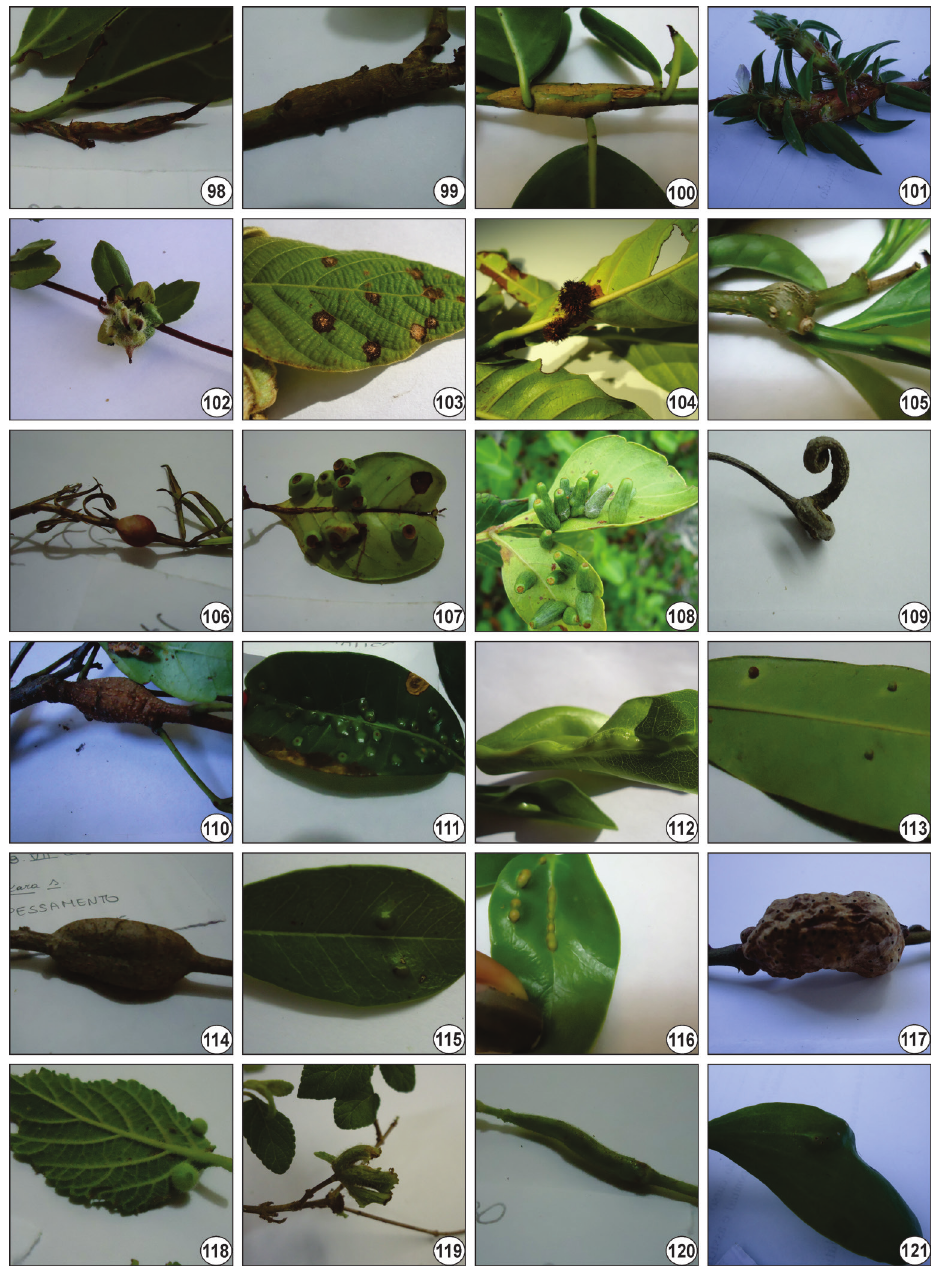
Figs. 98-121 - Galling insects from Parque Estadual da Costa do Sol and RPPN Fazenda Caruara (RJ, Brazil). 98, Coccoloba rigida , stem gall. 99, Myrsine parvifolia , stem gall. 100, Scutia arenicola , stem gall. 101, Diodella apiculata , stem gall. 102, Enhydra sessilis , bud gall. 103, Ladenbergia hexandra , lenticular leaf gall. 104-105, Psychotria carthagenensis , 104, globoid leaf gall, 105, stem gall. 106, Spermacocae verticilata , stem gall. 107, Paullinia racemosa , conical leaf gall. 108-110, Paullinia weinmanniaefolia , 108, conical leaf gall, 109, tendril gall, 110, stem gall. 111-112, Chrysophyllum lucentifolium , 111, lenticular leaf gall, 112, leaf vein gall. 113-114, Manilkara subsericea , 113, globoid leaf gall, 114, stem gall. 115, Sideroxylum obtusifolium , lenticular leaf gall. 116-117, Smilax rufescens , 116, leaf vein gall, 117, stem gall. 118-120, Lantana fucata , 118, globoid leaf gall, 119, cylindrical leaf gall, 120, stem gall. 121, Phoradendron quadrangulare , globoid leaf